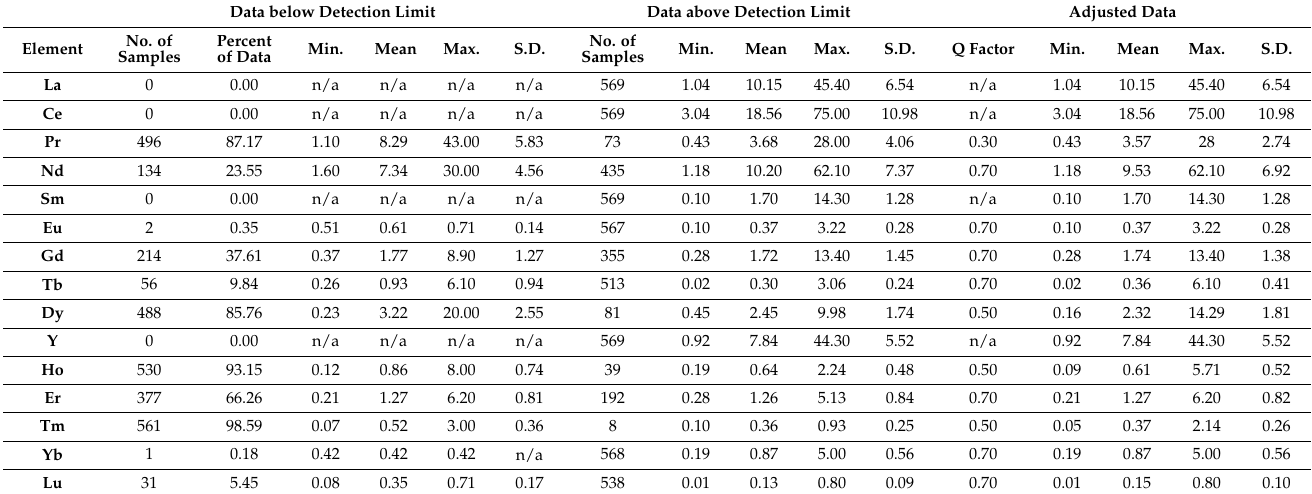
Table 1. Summary statistics for below detection limit (BDL), above detection limit (ADL), and Q factor-adjusted data. Minimum (Min.), mean, and maximum (Max.) values in ppm (whole coal-basis). S.D. is standard deviation; n/a means not